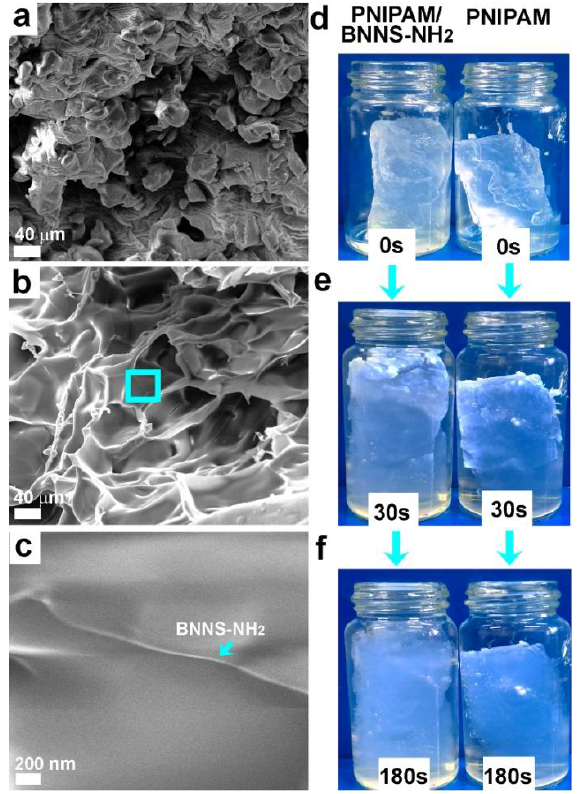
Figure 1. SEM images of the lyophilized hydrogels ( a ) PNIPAM, ( b ) PNIPAM/BNNS-NH 2 , and ( c ) magnification at cross-section in ( b ). Photographs of the hydrogels placed in hot water (42 °C) (the left one is PNIPAM/BNNS-NH 2 , the right one is pure PNIPAM): ( d ) before poured into hot water, ( e ) 30 s later and ( f ) 180 s later placed in hot water (42 °C).